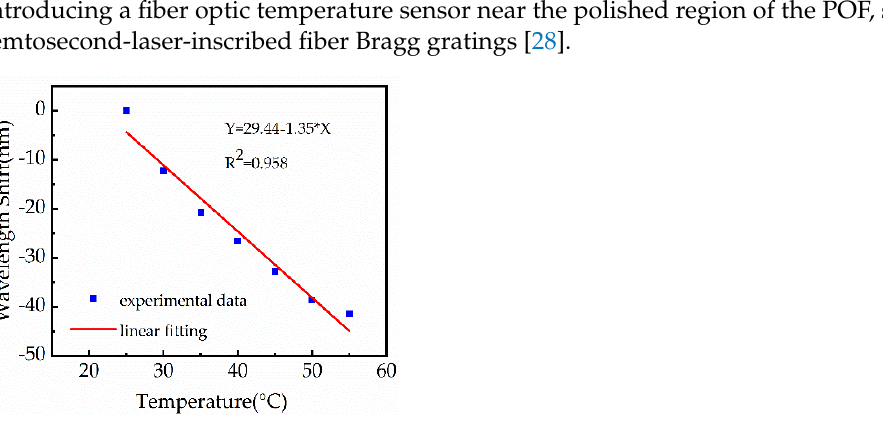
Figure 9. Sensor wavelength shifts as the temperature varied from 22 °C to 55 °C.